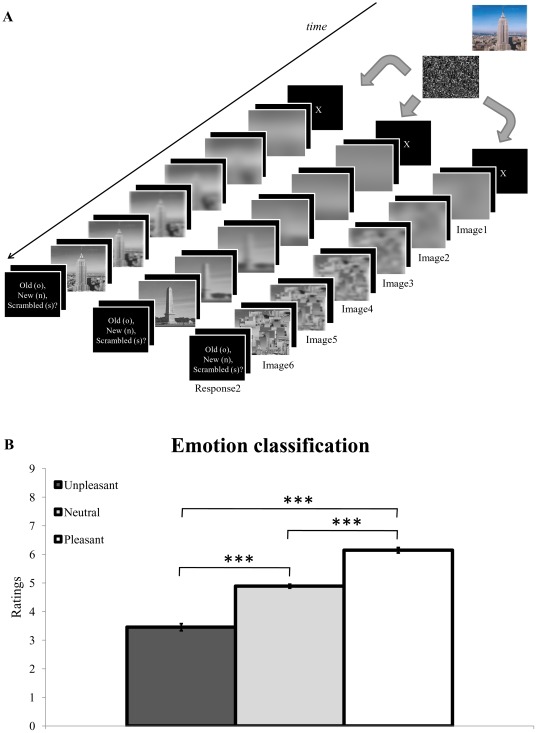
Trial presentation and results of the emotional classification task.(A) Main trial types during the progressive unfolding experiment. A colorful neutral, unpleasant or pleasant IAPS scene (not shown here for copyright reasons) was first presented for 1500 ms, in random order. Following a 2000 ms uniform mask, the same scene (45%), a new one (45%), or a scrambled picture (10%) was progressively revealed in grayscale, using six successive steps varying in a monotonic fashion regarding the content of LSF and HSF information. Each image level was presented for 500 ms, followed by a 250 ms blank screen. Participants had to press a pre-defined button as soon as they could decide whether the gradually unfolded scene was the one seen at the beginning of the trial, a new one, or a scrambled picture (Response1). Five hundred milliseconds after Response1, participants validated their choice and indicated whether the scene was “old”, “new” or “scrambled” by pressing one out of three buttons (Response2). (B) Results of the emotion classification task (occurring after Response2 on 10% of the trials) showed higher scores (corresponding to more pleasant pictures) for pleasant scenes (white bar), followed by neutral (light grey bar) and unpleasant (dark grey bar) scenes. *** p<.001. Vertical bars correspond to standard errors of the means.